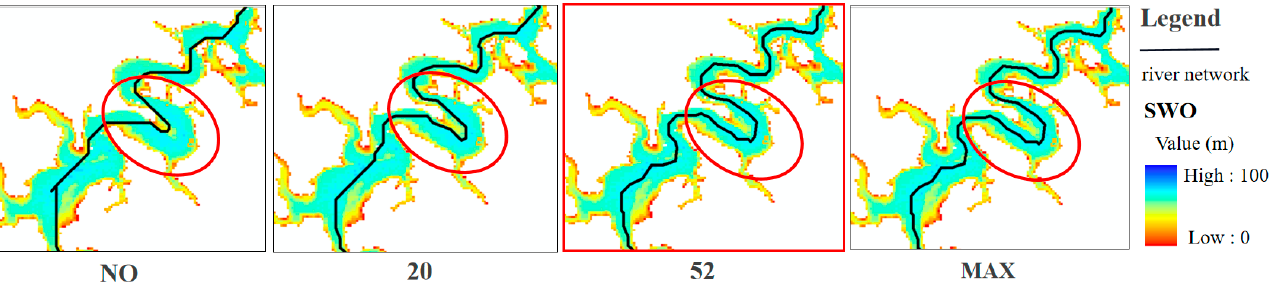
Figure 11. Comparison between the different sharp drop/raise grids of AGRSDEM (significant changes are marked in red).